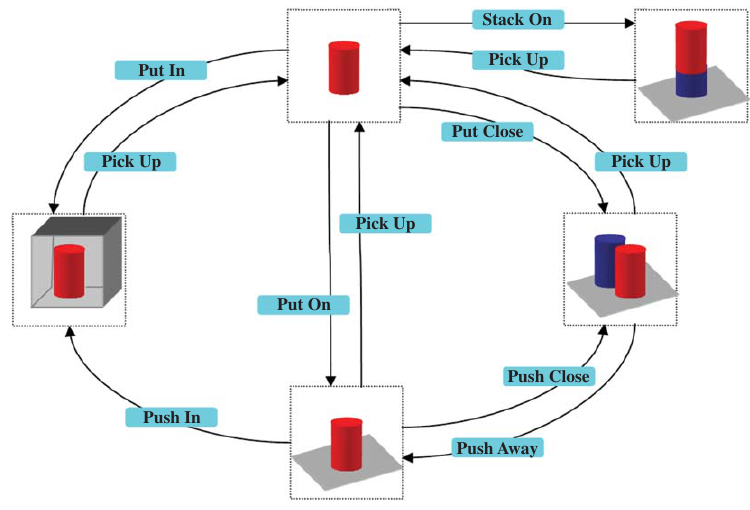
Fig. 1. An object schema representation for the possible set of primitive actions for the object